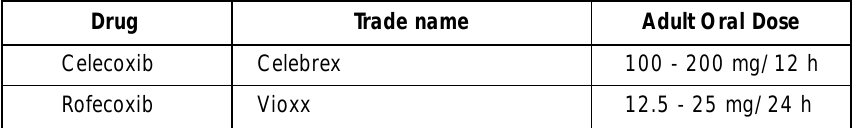
Table 2: Some generic and selected trade names for systemic NSAIDs (specific COX-2 inhibitors)